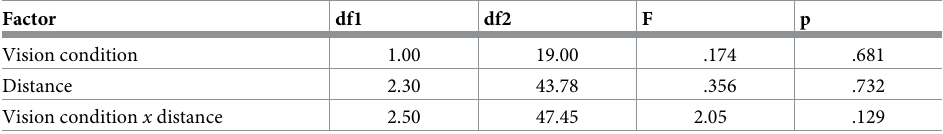
Table 9. Results of the two-factor ANOVA with repeated measures (6 distances; 2 vision conditions) for the abso- lute error of the predicted putt length. Corrected by Greenhouse-Geisser � .